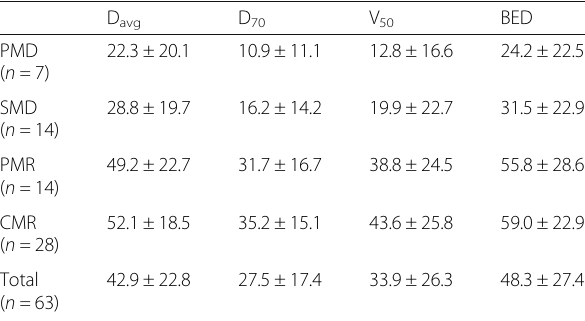
Table 2 Response rates of lesions for different 90 Y absorbed